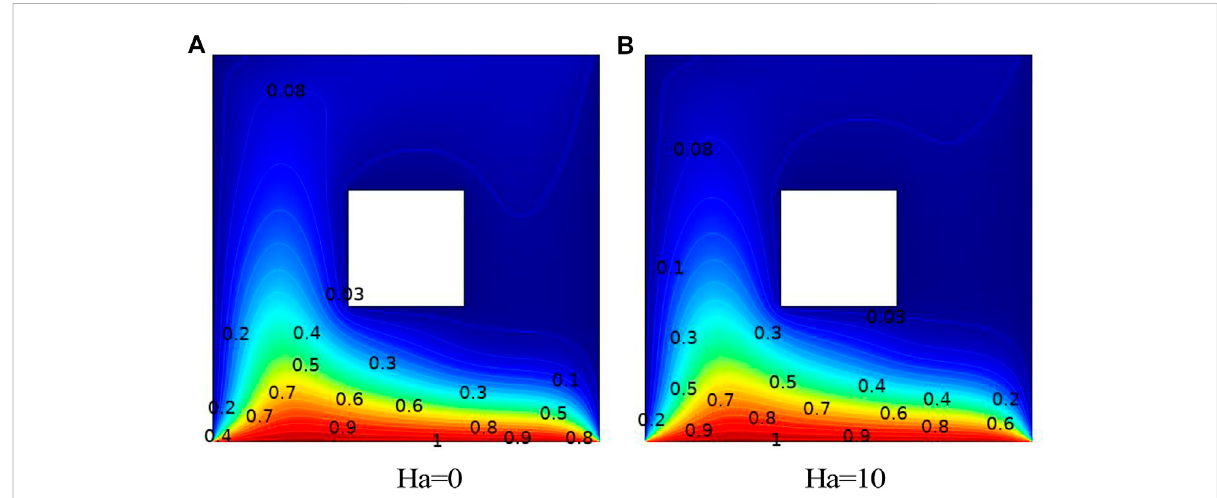
FIGURE 7 In fl uence of Ha on isotherms with a uniformly heated bottom wall: cold cylinder case, Re (cid:2) 100 and Gr (cid:2) 10 4 .